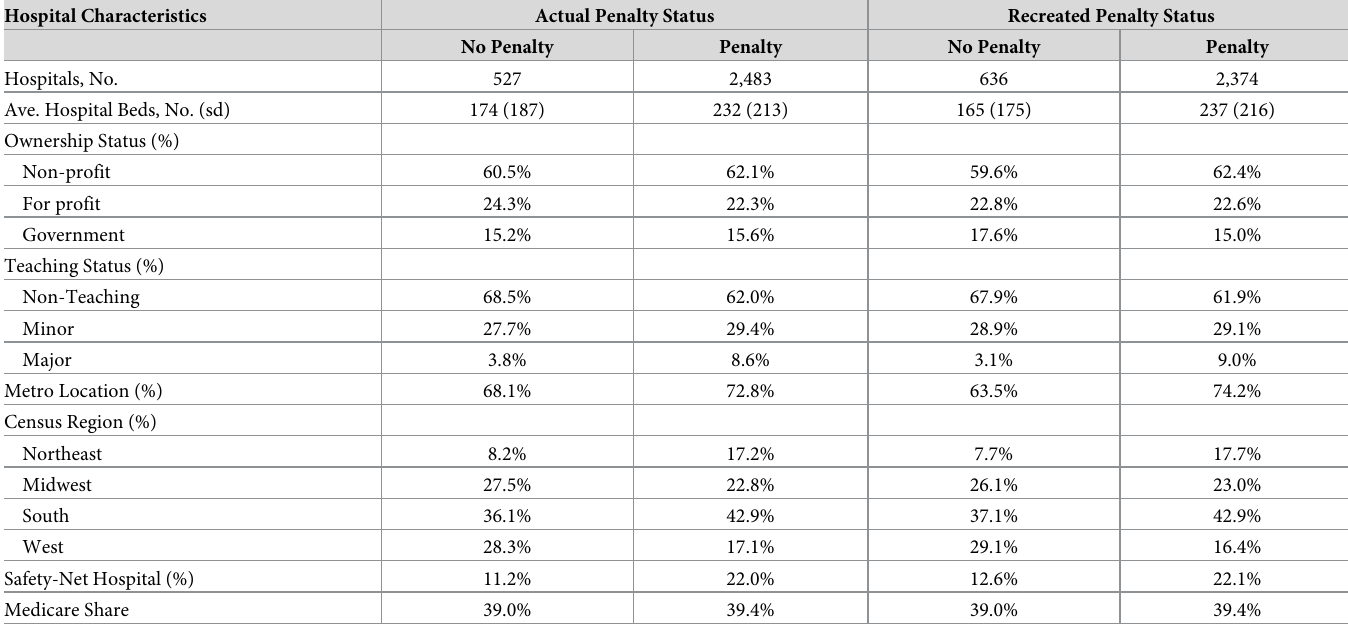
Table 1. Hospital characteristics by actual and recreated penalty status for FY2015 � . Hospital